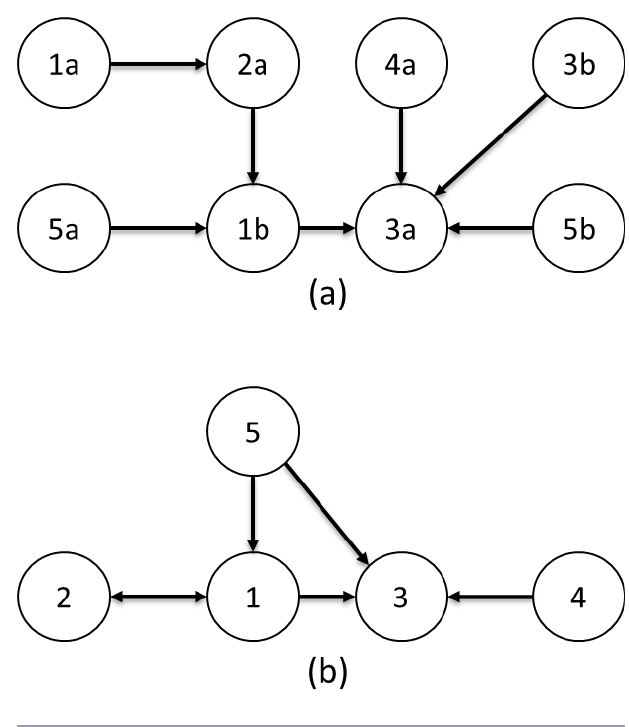
Fig. 3 . Schematics showing plot-plot networks (a) and individual-individual networks